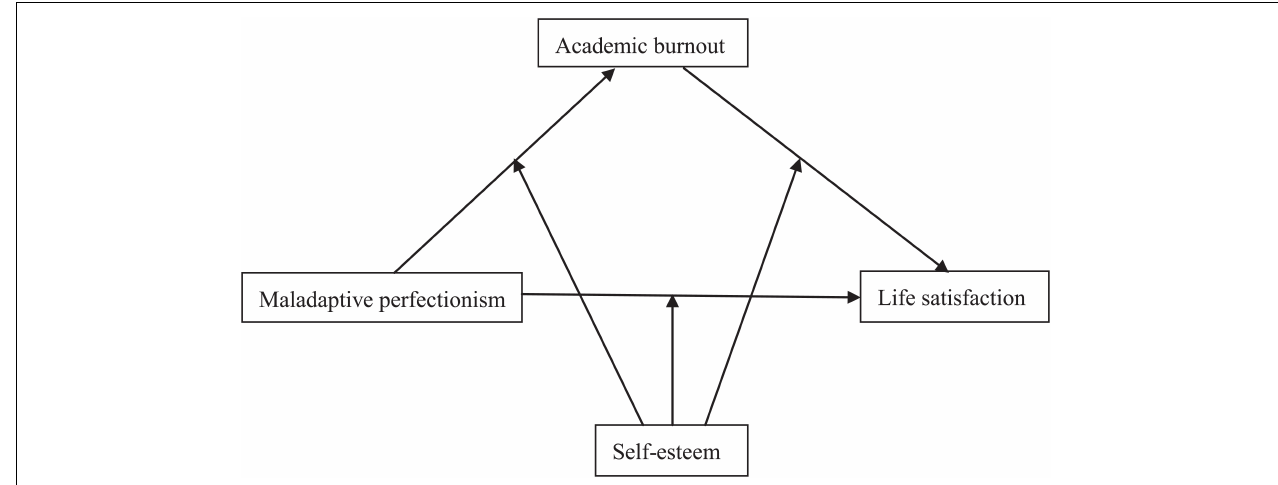
FIGURE 1 | The conceptual model of the current research.